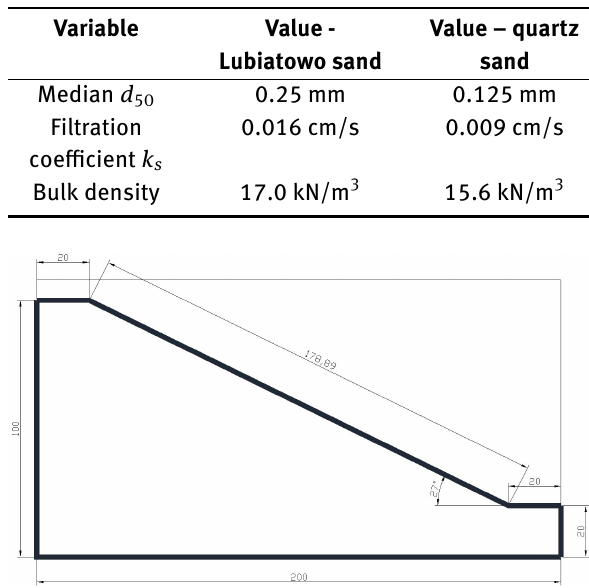
Table 1: Characteristics of the Lubiatowo and quartz sand used to the tests.